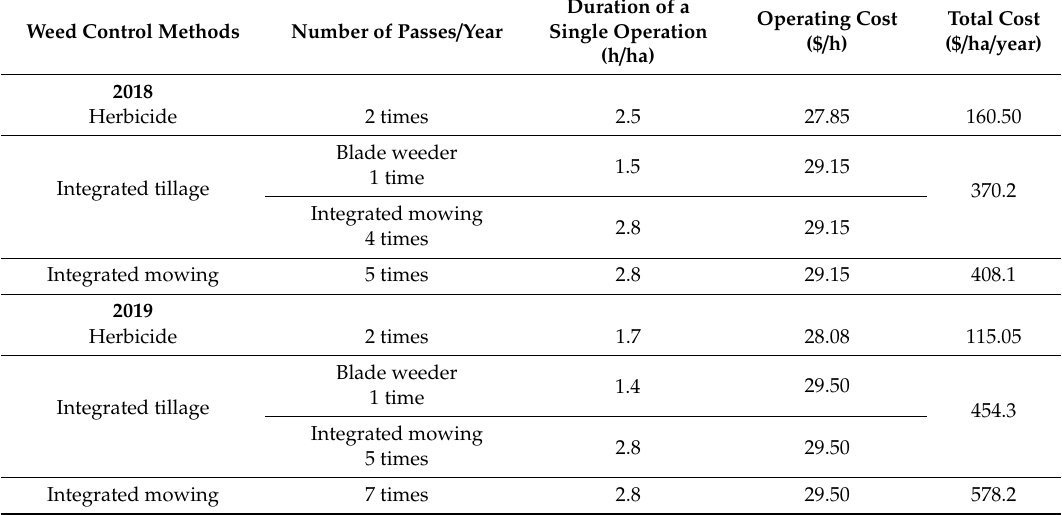
Table 6. Costs of weed control methods in the two commercial apple and peach orchards in 2018 and 2019 in Valdaso (Italy).